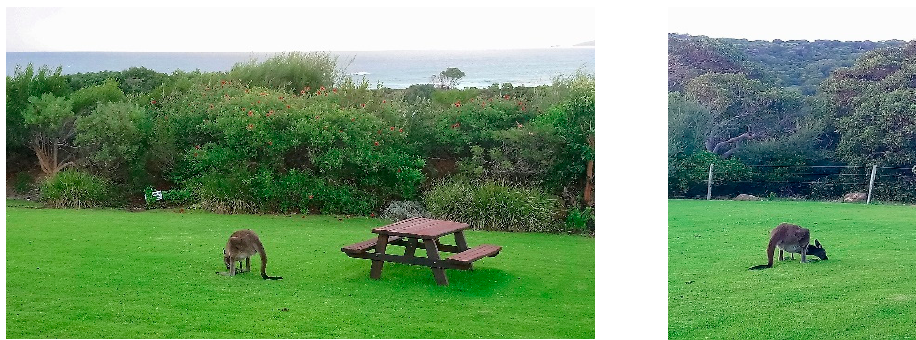
Figure 11. Urban lawns have become a desirable food source for Kangaroos in Western Australia. Photos: M. Ignatieva.